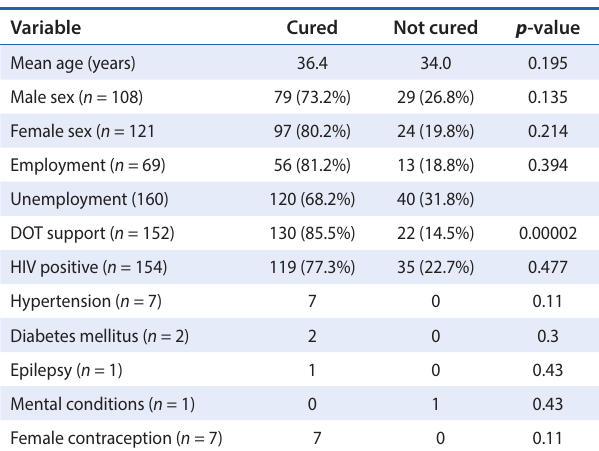
Table 3: Association between variables and cure